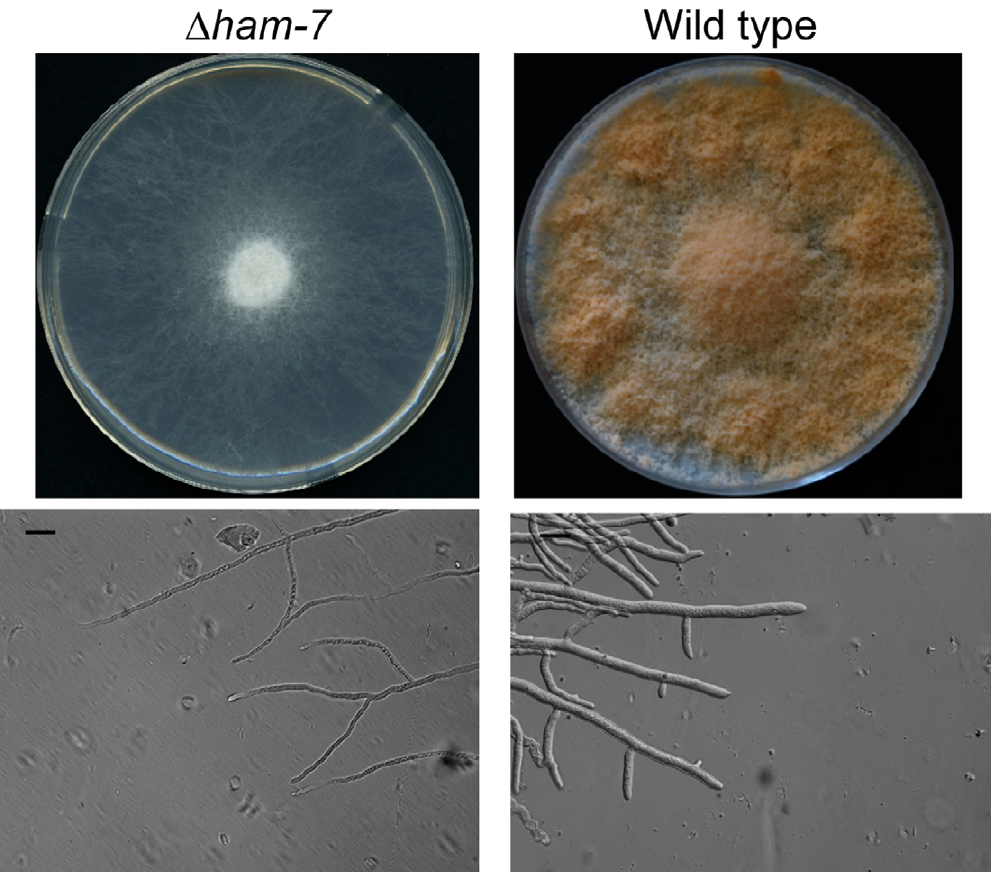
Figure 4. D ham-7 morphologies. In the upper panels, the colonial morphology of D ham-7 and wild type are shown for cells grown on a Vogel’s sucrose agar medium for 48 hours. The morphology of the hyphae at the edge of a 24 hour colony growing between two sheets of cellophane is shown for wild type and mutant cells in the lower panels. The black bar represents a distance of 20 m m.